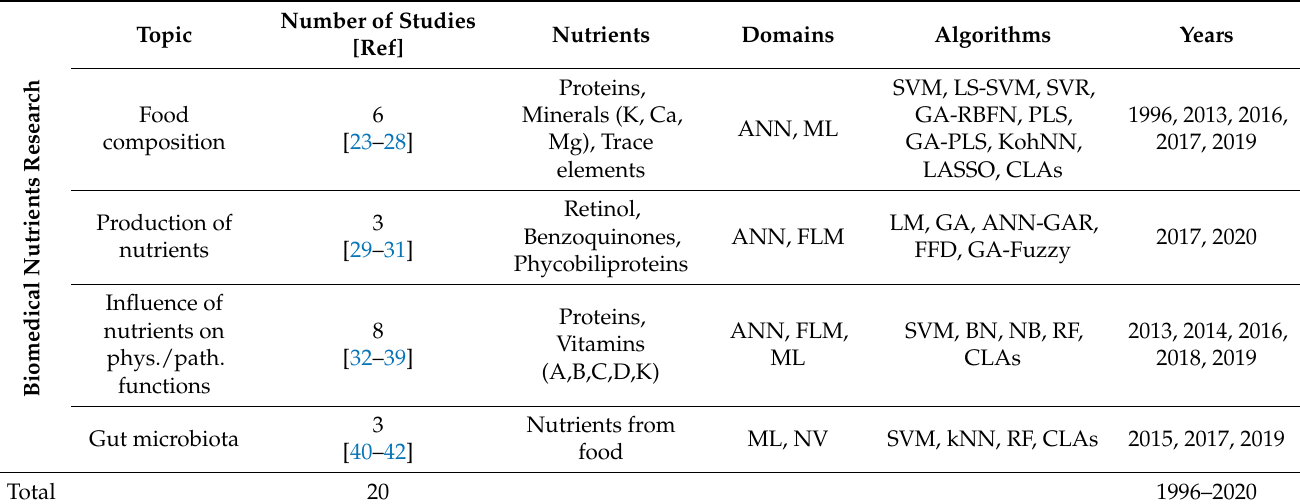
Table 1. The characteristics of the included studies on biomedical nutrients